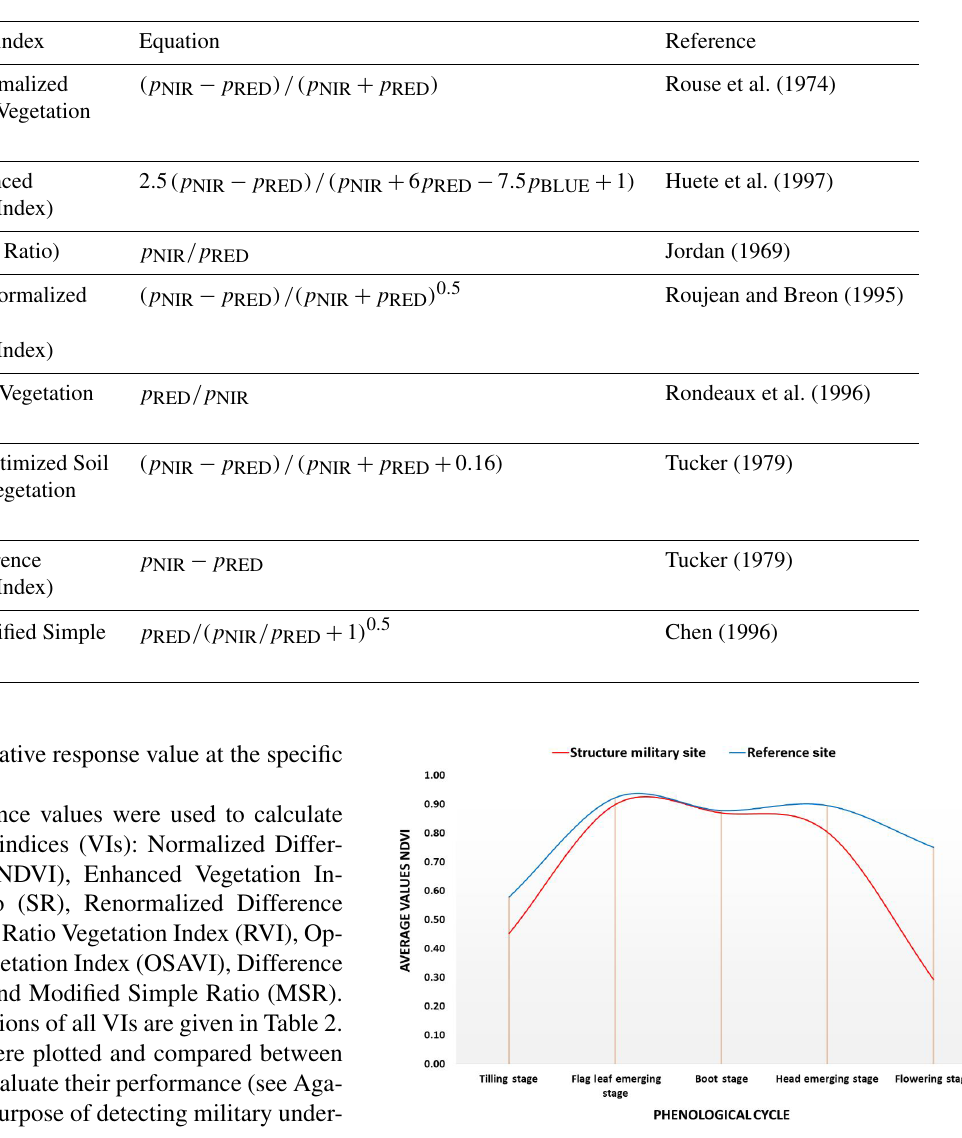
Table 2. Vegetation indices: p NIR , p RED , p BLUE and p GREEN represent the atmospherically or partially atmospherically corrected surface reflectance values of the near-infrared (NIR), red (RED), blue (BLUE) and green (GREEN) wavelengths, respectively (Agapiou et al., 2012).